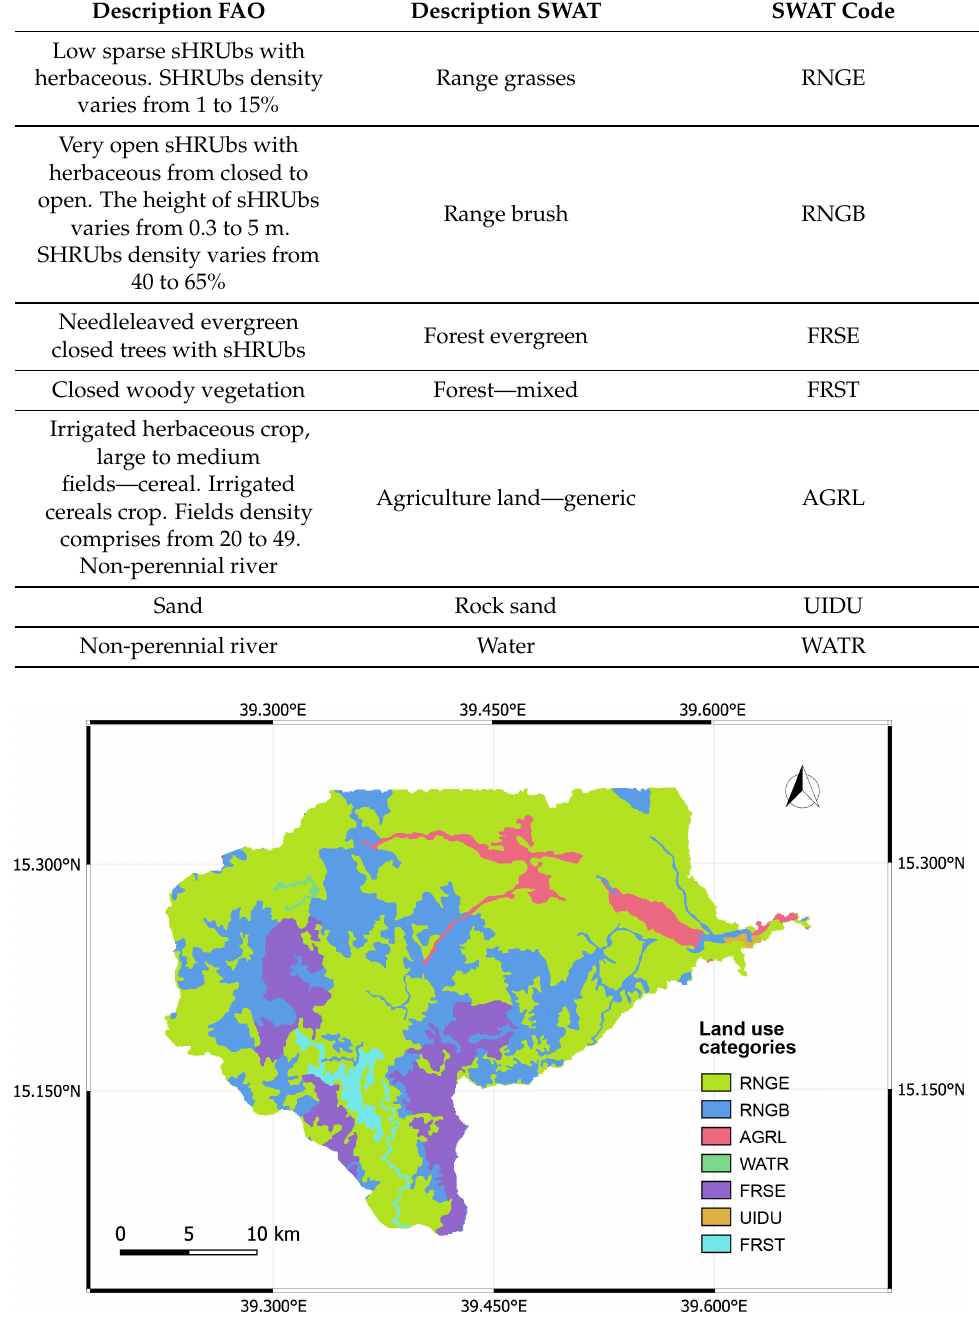
Figure 3. Land cover map: RNGE (range grasses), RNGB (range brush), AGRL (agriculture land— generic), WATR (water), FRSE (forest evergreen), UIDU (rock sand), FRST (forest—mixed).